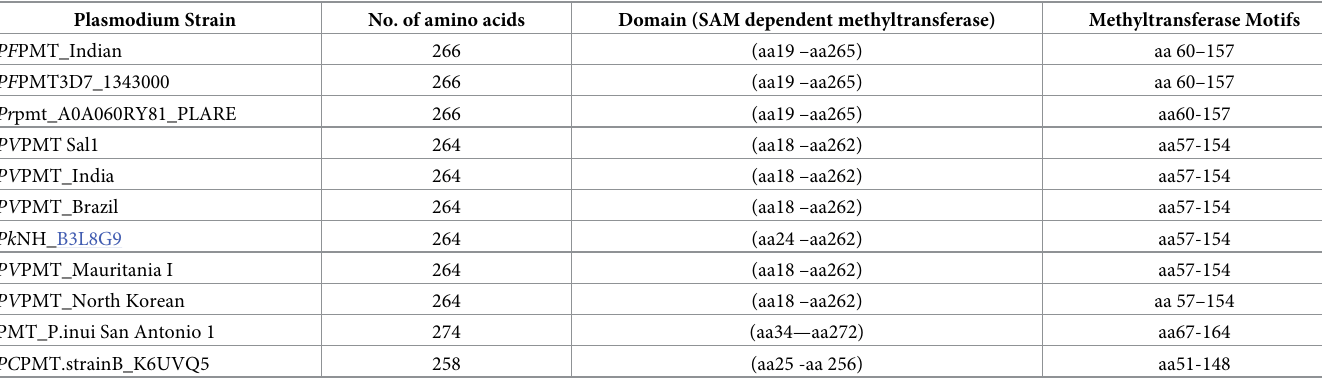
Table 1. Depicted domain and motifs scan of PMT proteins of Plasmodium species. Plasmodium